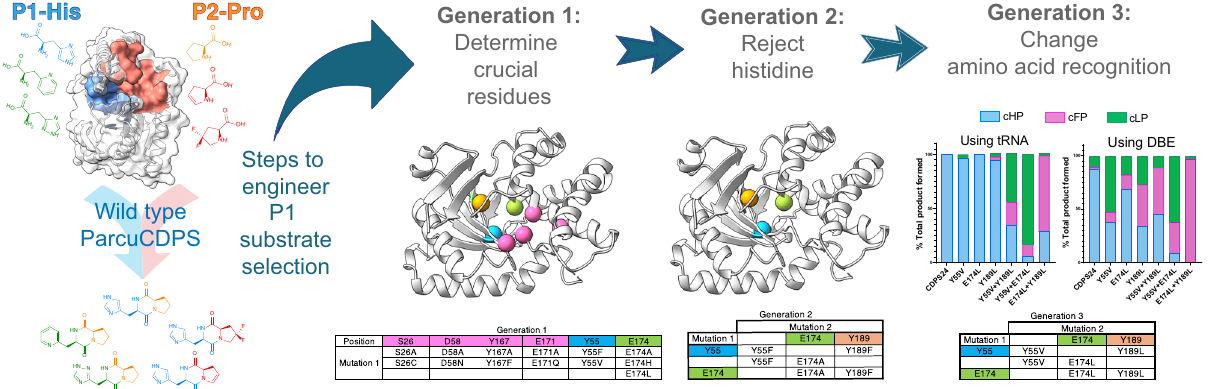
Fig. 6 Swapping the substrate selection on P1 by Parcu CDPS. Based on P1 residues we produced a series of rationally designed mutants to determine residues crucial for histidine recognition (Generation 1); reject histidine as a substrate (Generation 2) and select a different amino acid on P1 to produce cyclic dipeptides that no longer contain histidine (Generation